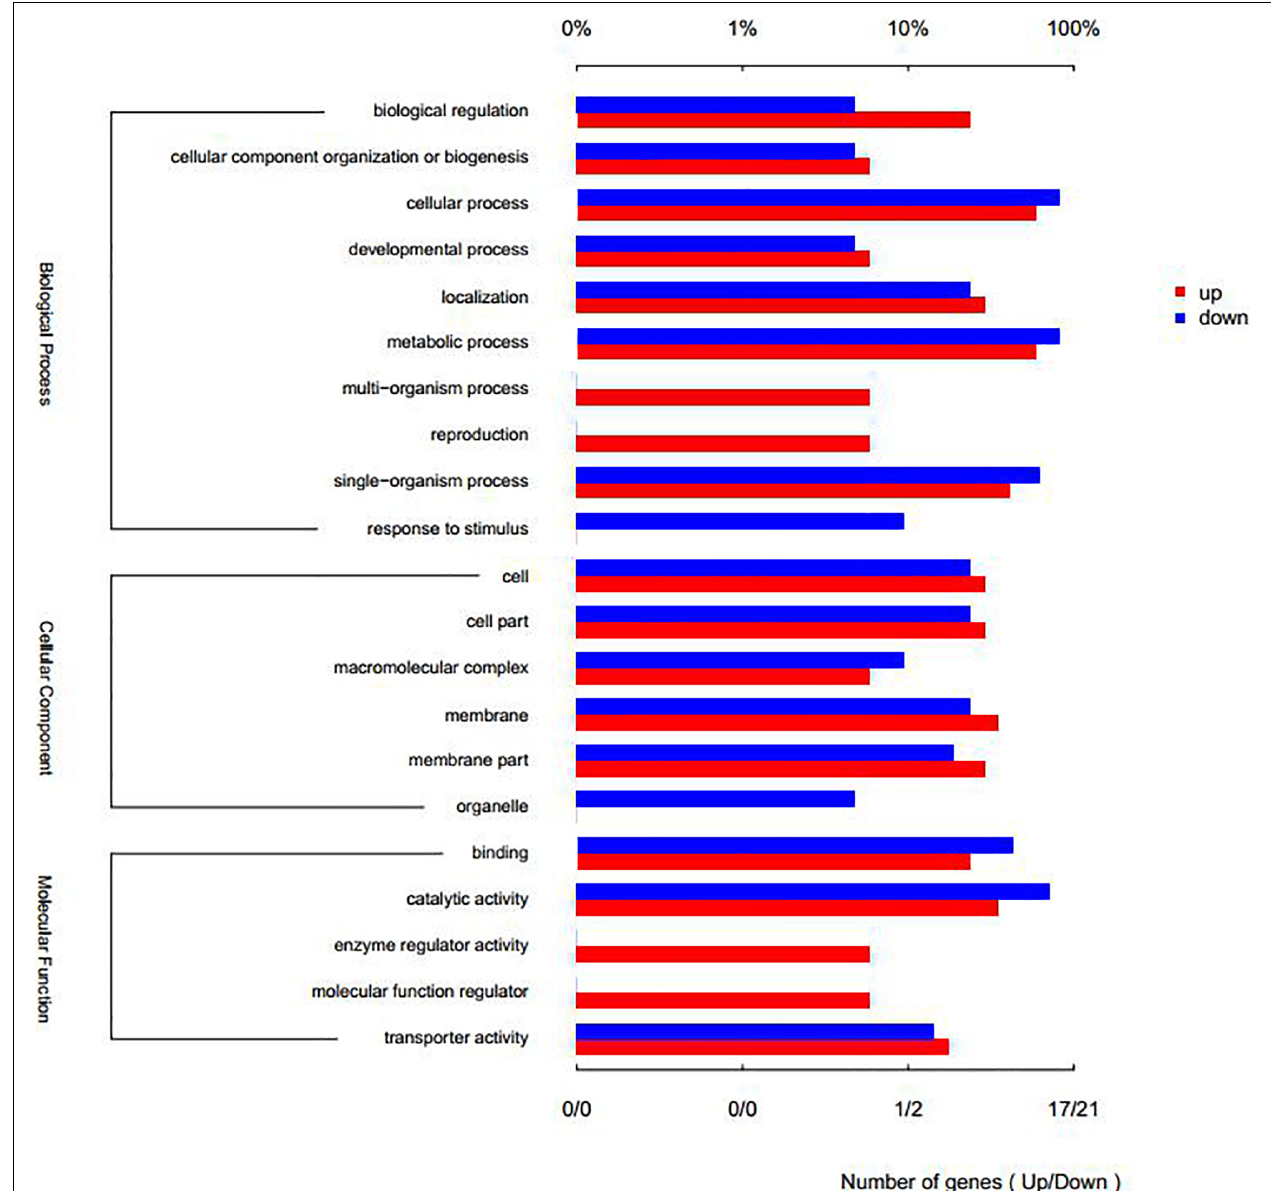
FIGURE 7 | Column map of GO annotation for up-and-down differential